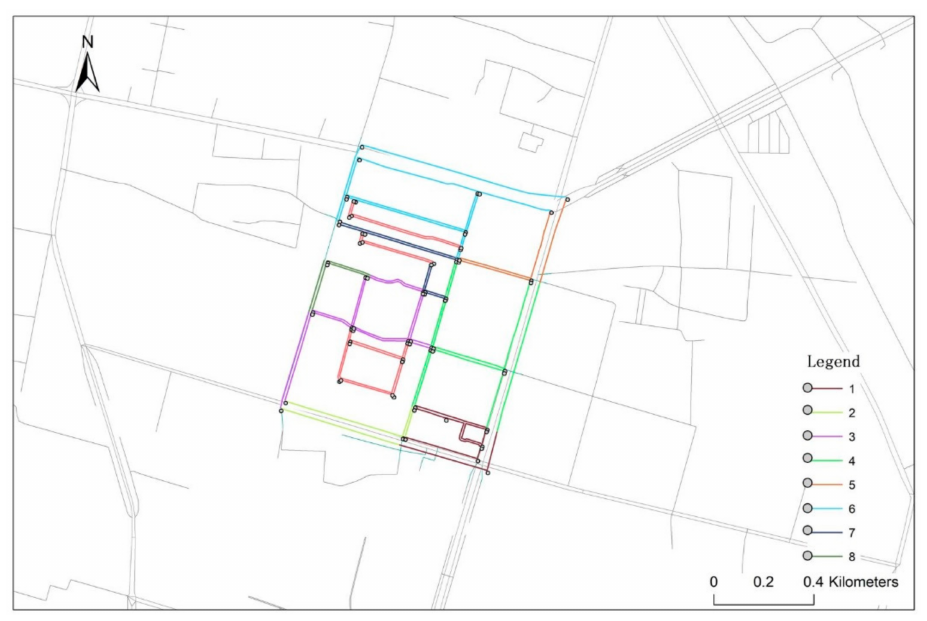
Figure 4. Initial route before optimization in real